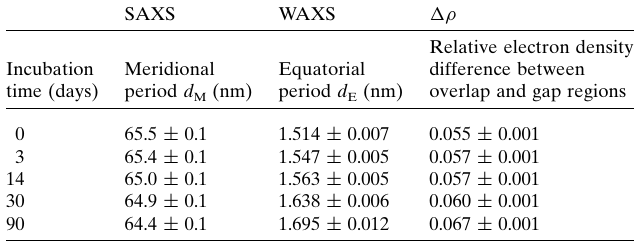
Table 1 SAXS/WAXS parameters measured on collagen in a 40 mg ml (cid:2) 1 ribose solution.